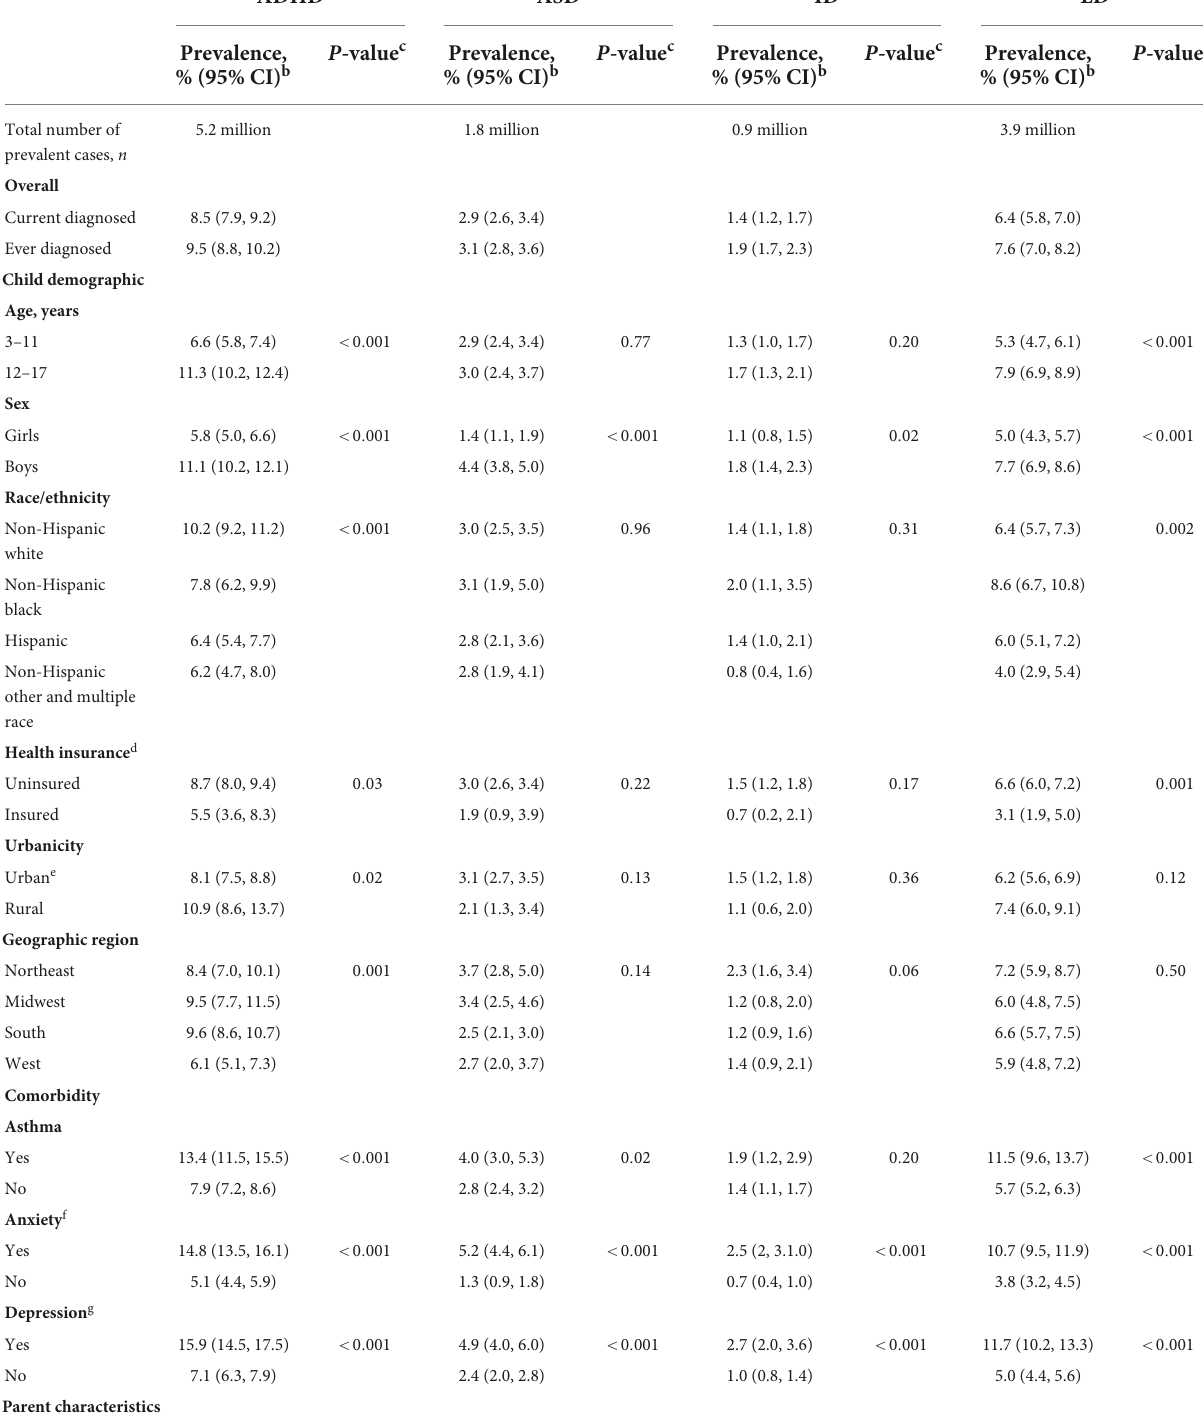
TABLE 1 Prevalence of cause-specific neurodevelopmental disorders among US children and adolescents aged 3–17 years in 2019 and 2020 a